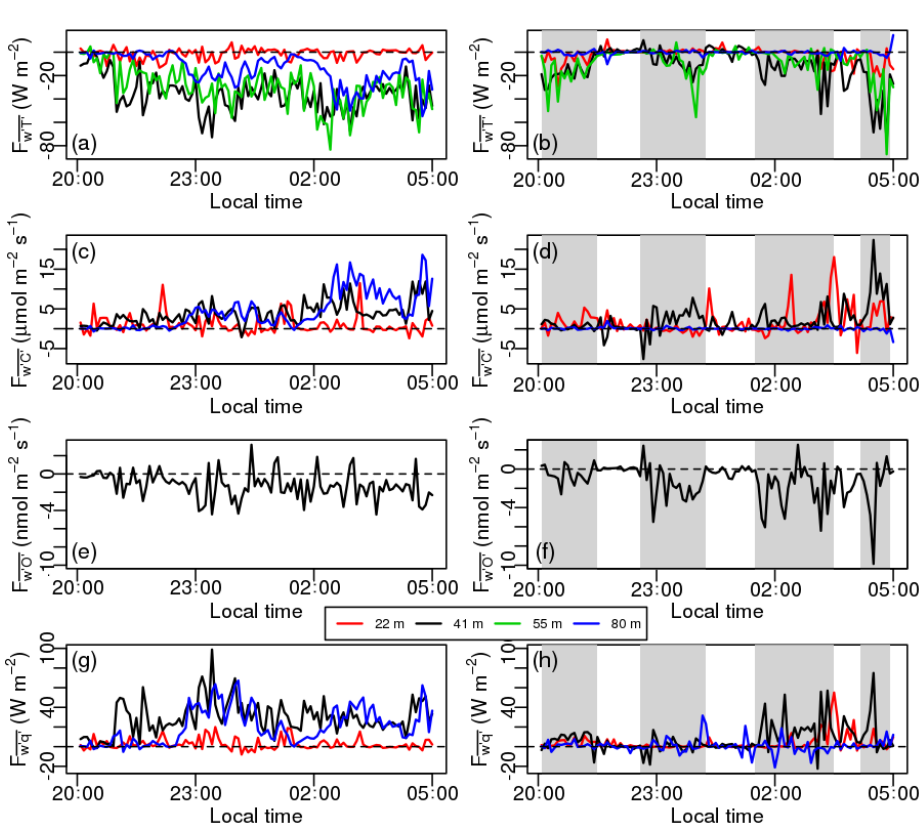
Figure 5. Fluxes of sensible heat ( a and b ), CO 2 ( c and d ), O 3 ( e and f ), and latent heat ( g and h ) for the turbulent night ( a , c , e , g ) and for the intermittent night ( b , d , f , h ). Shaded areas indicate intermittent turbulence bursts as shown in Fig.